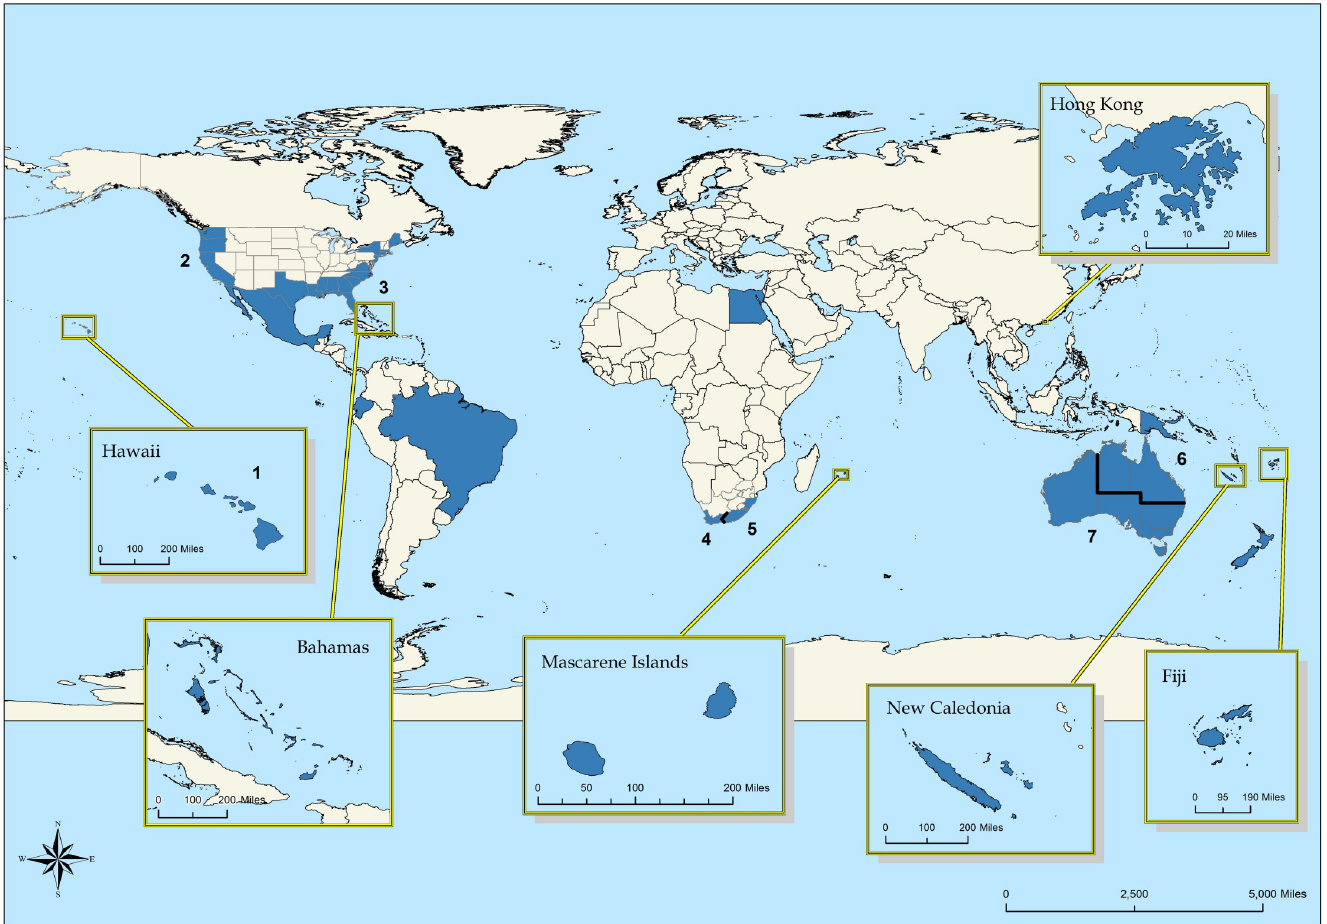
Fig 1. World map of countries (and regions) included in our analysis. Countries ( n = 14) included are shown in blue, while regions are represented by numbers ( n = 7) and are areas within the USA, the Republic of South Africa, or Australia.